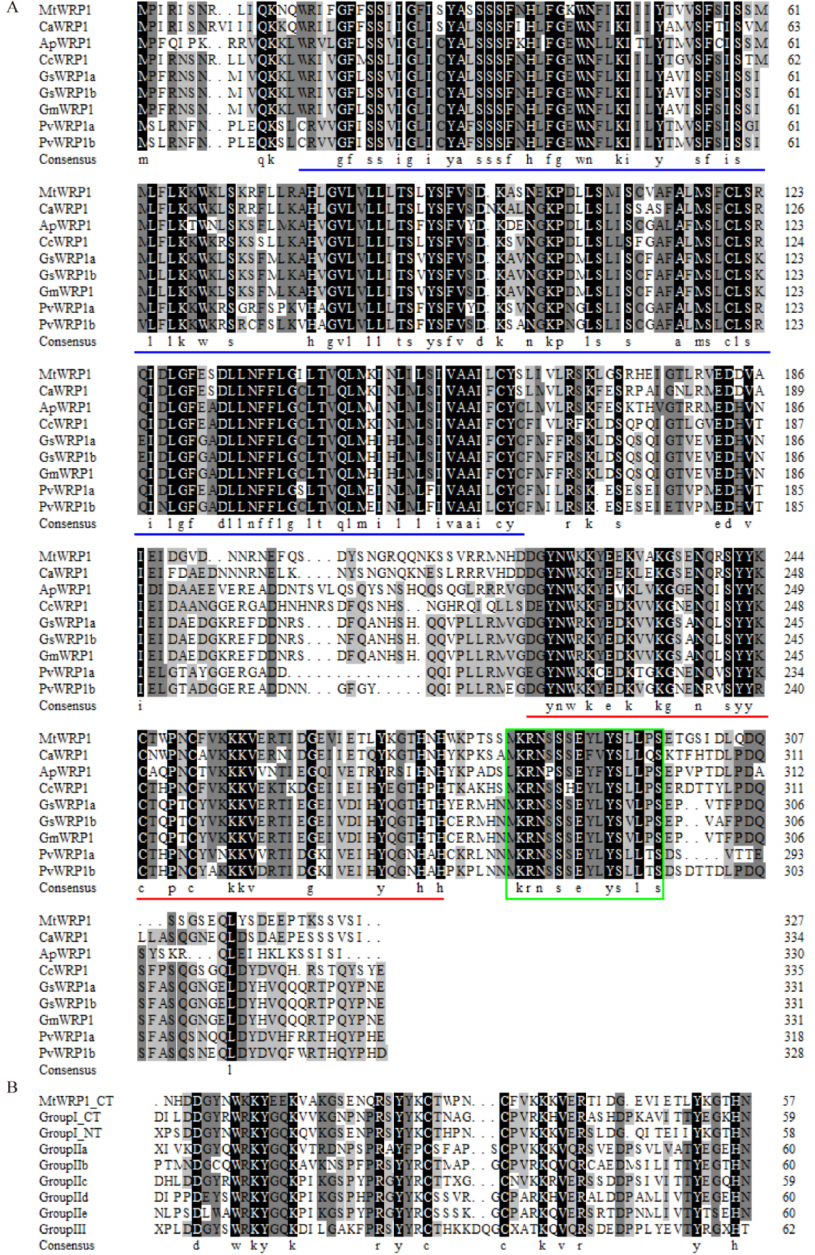
Figure 1. Multiple amino acid sequence alignment: ( A ) Close homologues of MtWRP1 in fabaceans. Amino acid sequences of the WRPs from M. truncatula (MtWRP1), Cicer arietinum (CaWRP1), Abrus precatorius (ApWRP1), Cajanus cajan (CcWRP1), Glycine soja (GsWRP1a and GsWRP1b), Glycine max (GmWRP1), and Phaseolus vulgaris (PvWRP1a and PvWRP1b). The TM domains of WRPs were indicated by blue lines. The WRKY domain of WRPs were indicated by red lines. The putative localization signals were indicated by the green box. ( B ) Alignment of the MtWRP1 WRKY domain sequence with the consensus sequences of the WRKY domains of seven WRKY subfamilies, including the N-terminal (NT) and C-terminal (CT) WRKY domains of group I WRKY proteins. The core sequences of the WRKY domain were indicated by